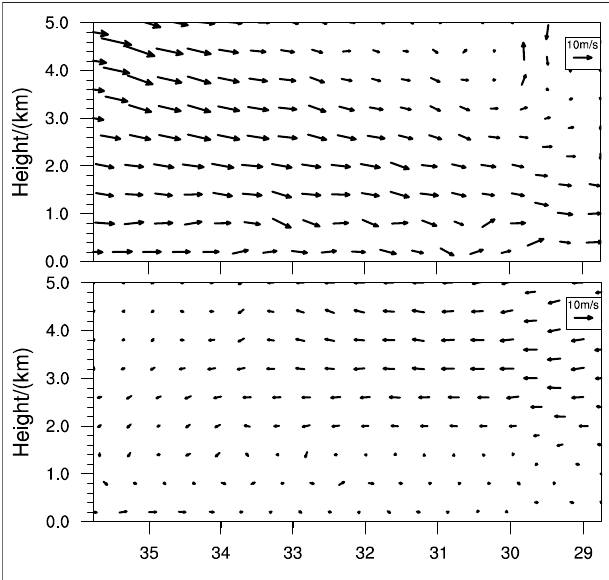
FIGURE 7 | The north-south cross-section (along with the red line in Figure 1 ) of the wind fi eld in the Jianghuai area (top) 0,800 19 – 12-2016 (bottom) 2000 23 – 12-